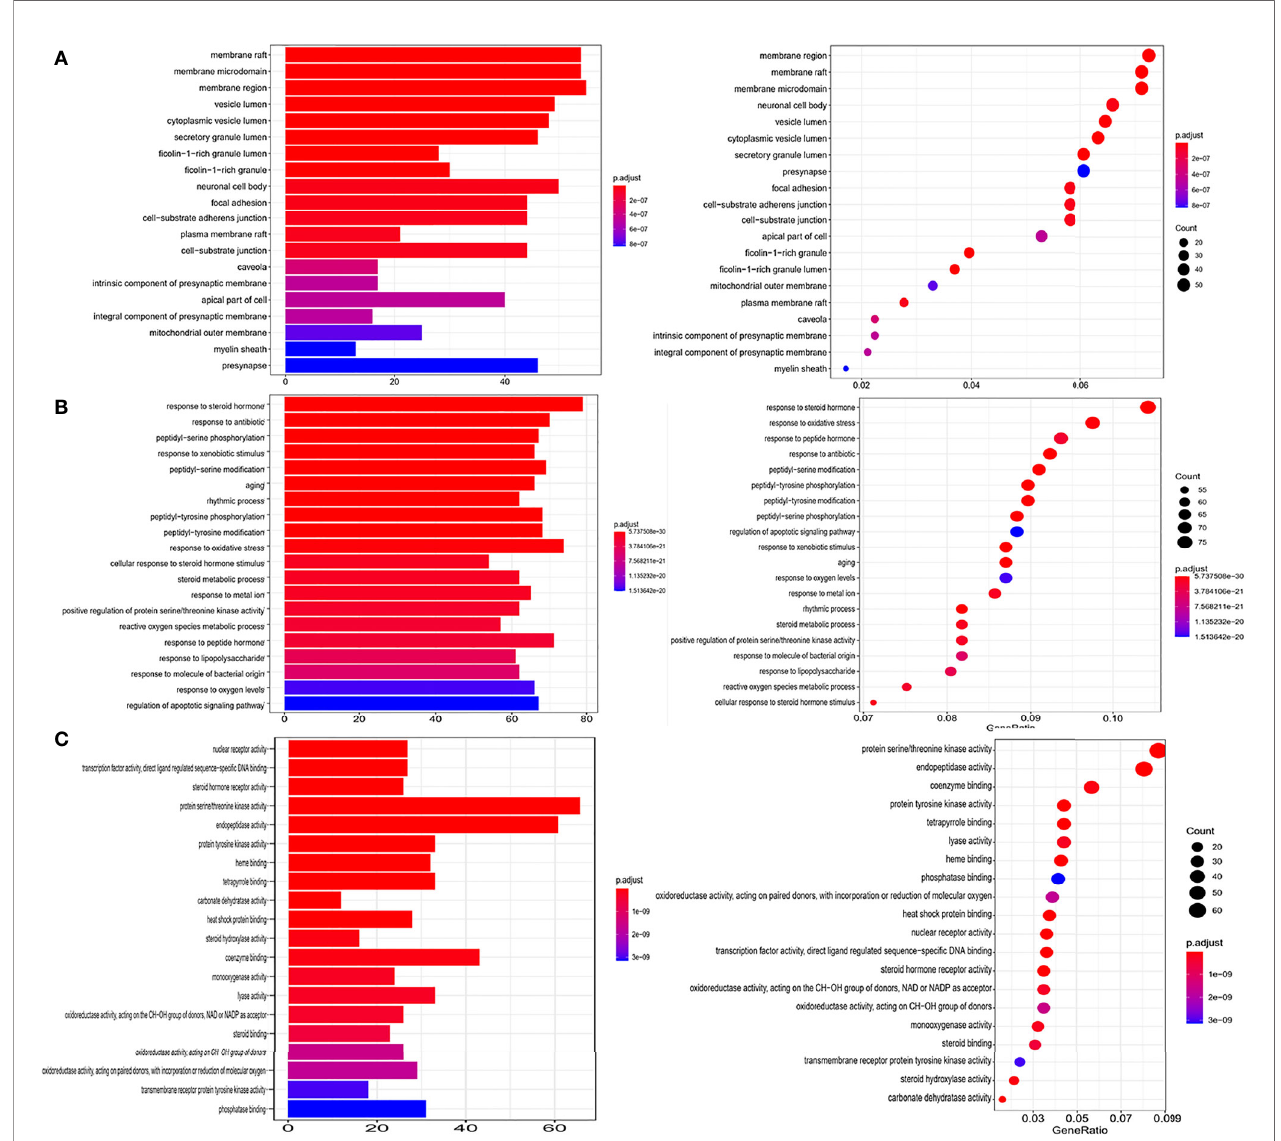
FIGURE 4 | GO functional enrichment analysis. (A) Cellular component category. (B) Biological process category. (C) Molecular function